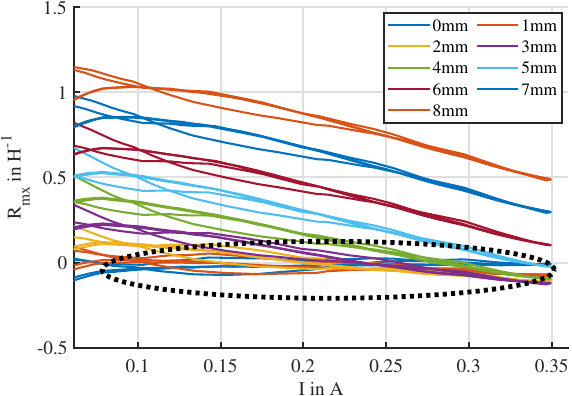
Figure 17. Air gap reluctance R mx over the current for different positions. The ellipse highlights the area of working points, which are not suitable for position estimation due to